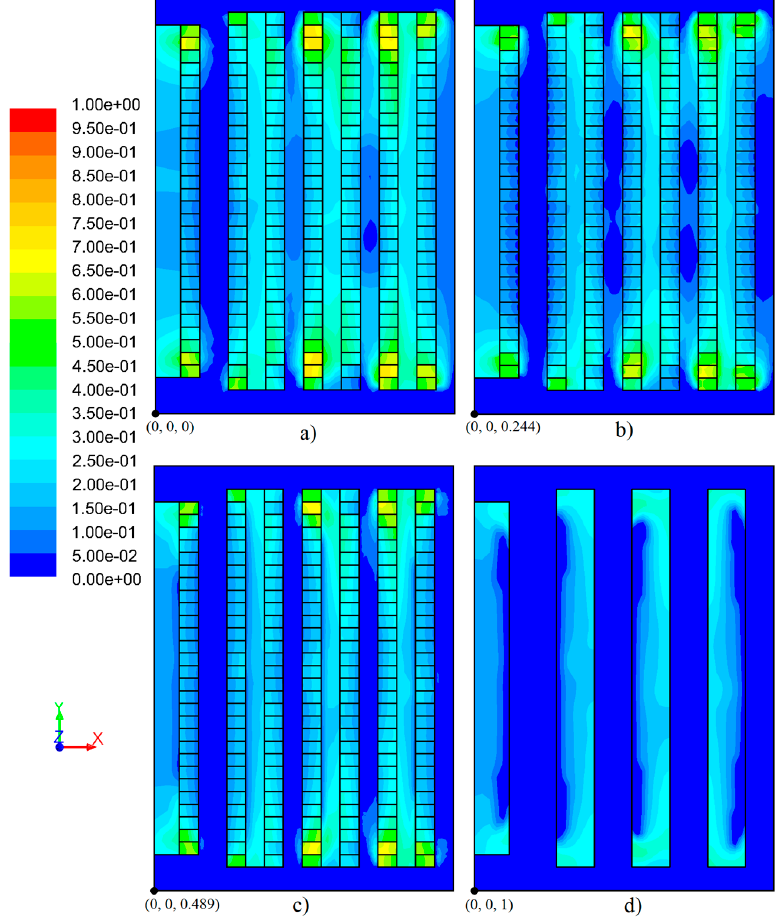
Figure 14. The results of the field of temperature in the x–y plane through the planes: ( a ) z adm = 0; ( b ) z adm = 0.244; ( c ) z adm = 0.489; and ( d ) z adm = 1.